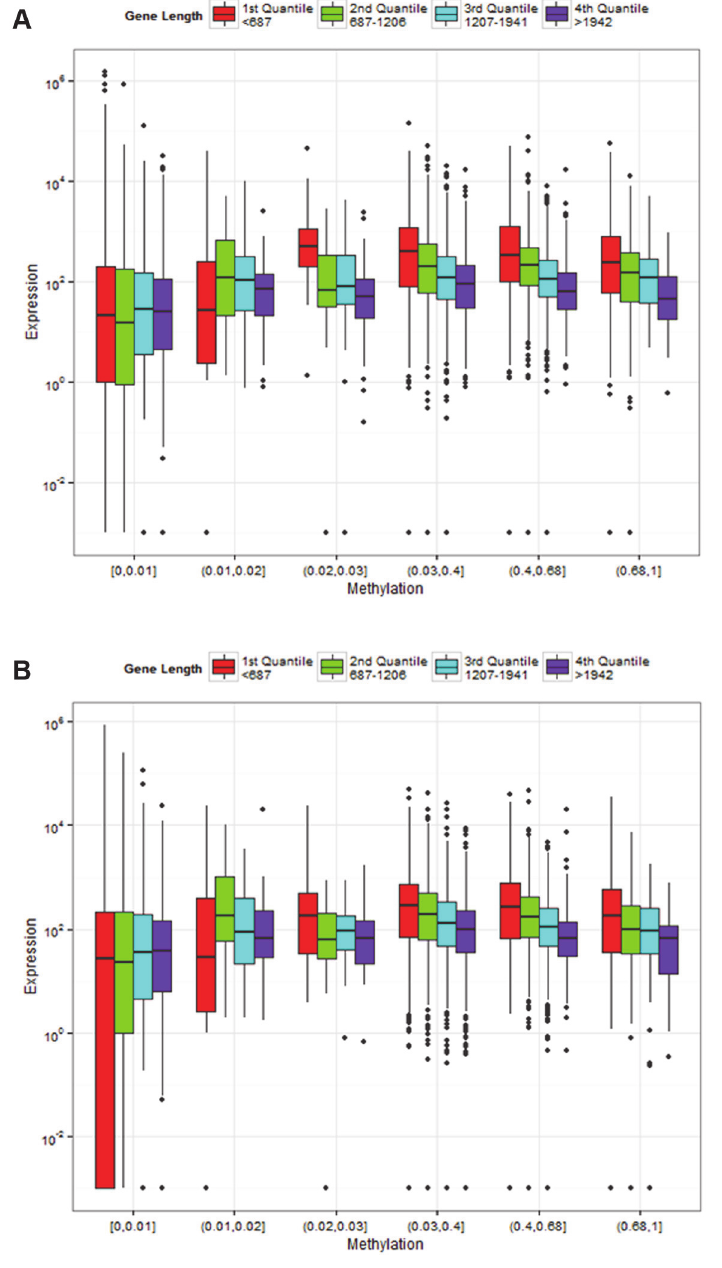
Fig 6. Association of gene length and fractional methylation with gene expression. Relationship between gene expression and DNA methylation is confounded by gene lengths in (A) control and (B) treatment experiments. The y-axis is the normalized gene expression levels (normalized by TMM methods and then divided by gene length) shown in a log-transformed scale. The x-axis represents fractional methylation levels. The first three groups of genes are sparsely methylated genes divided into three similar sized bins. The last four groups are relatively heavily methylated genes. Methylated genes are first divided into three similar sized bins, and then the most heavily methylated genes (fractional methylation levels > 0.9) are shown separately to represent the relationship between gene lengths and expression more clearly. The last group (fractional methylation level > 0.9) does not include the longest quantile of